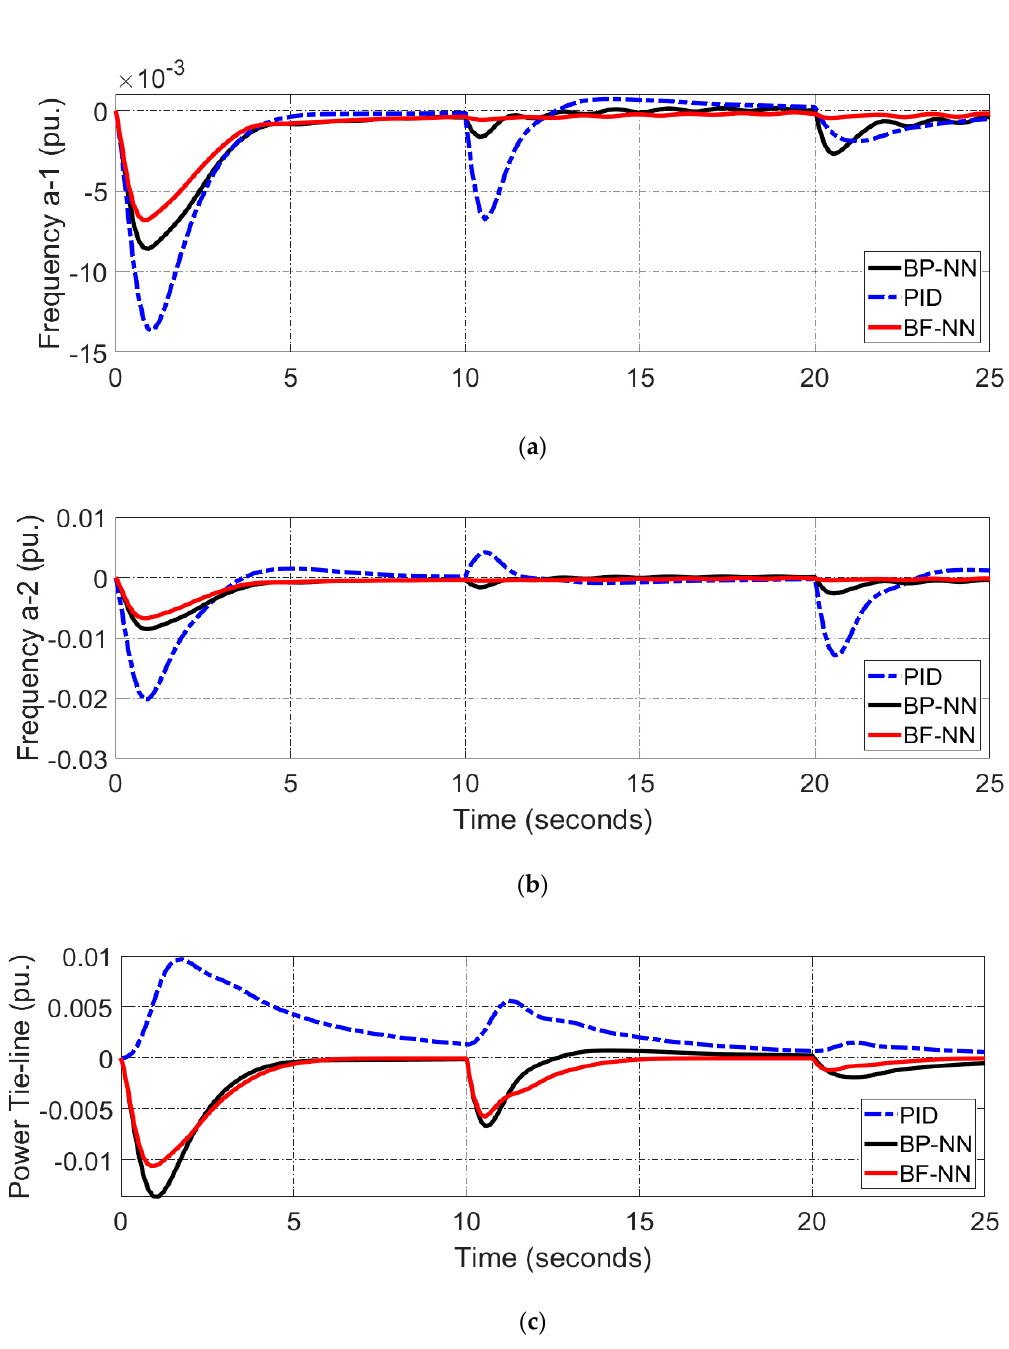
Figure 13. Division signals of a two-area hybrid power system in a mismatching operation state of ( a ) the output frequency of area 1, ( b ) the output frequency of area 2, and ( c ) the tie-line power with PV generation.